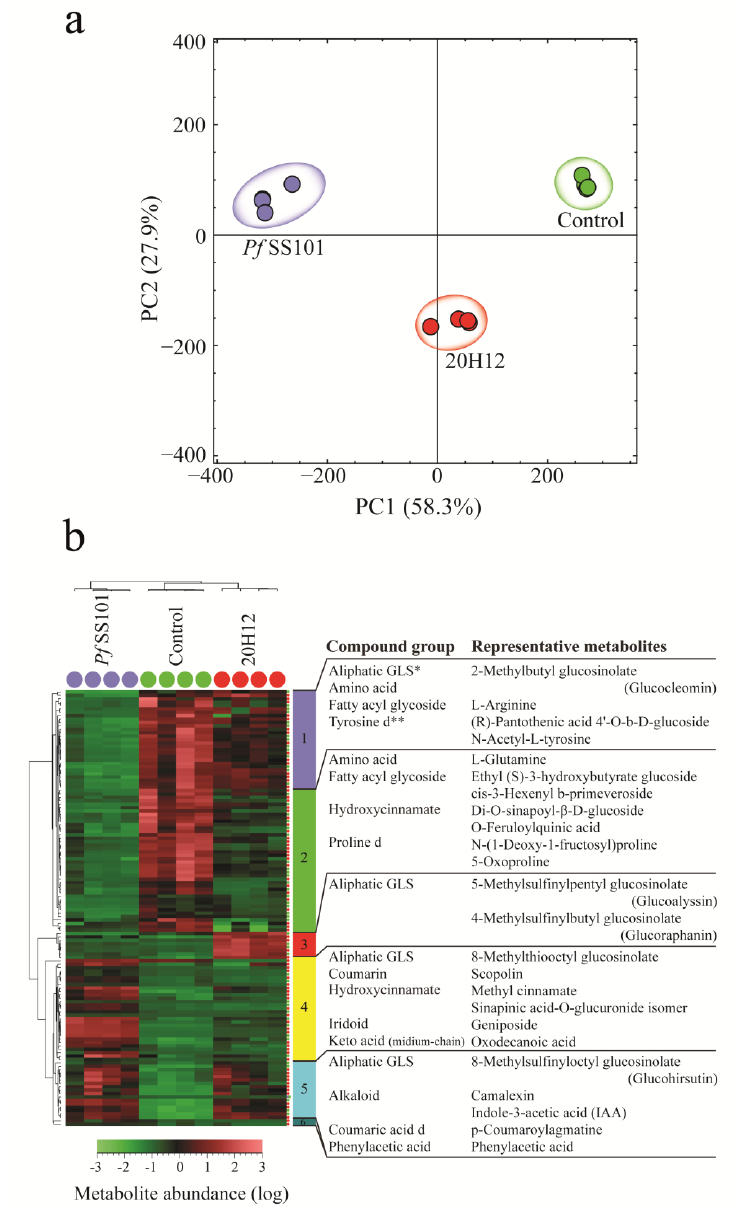
Figure 3. Metabolome changes in Arabidopsis shoots upon root treatment by P. fluorescens SS101 or its cysH mutant 20H12. Shown are the results of the principal component analysis (PCA) ( a ) and hierarchical cluster analysis (HCA) ( b ) based on the differentially regulated semi-polar metabolites. In the HCA, various metabolite clusters are indicated by different colors and when none of the metabolites in a given cluster was annotated, the cluster number was omitted (clusters 3, 5, and 10 in panel b). * GLS, glucosinolate; ** d, derivative.